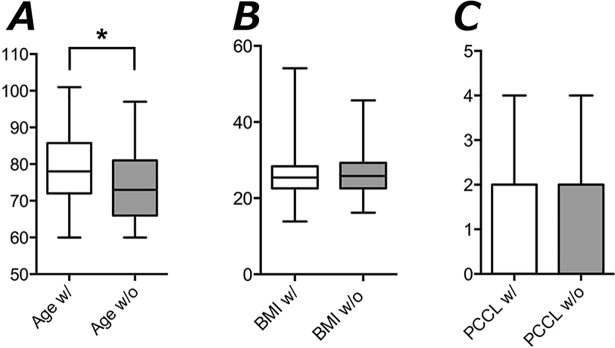
Boxplots (Mean, 25th to 75th percentiles, Min to max) of clinical data in patients with and without prior risk fractures: (* p < 0.05).(A) Age (B) Body mass index (BMI) (C) Patient Clinical Complexity Level (PCCL).